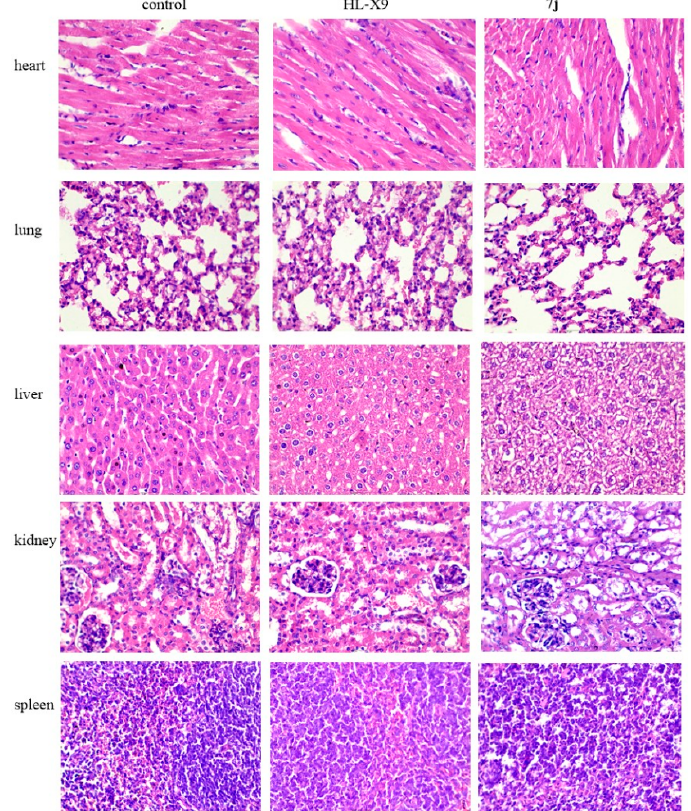
Figure 6. H&E staining of main tissues female mice after administration.